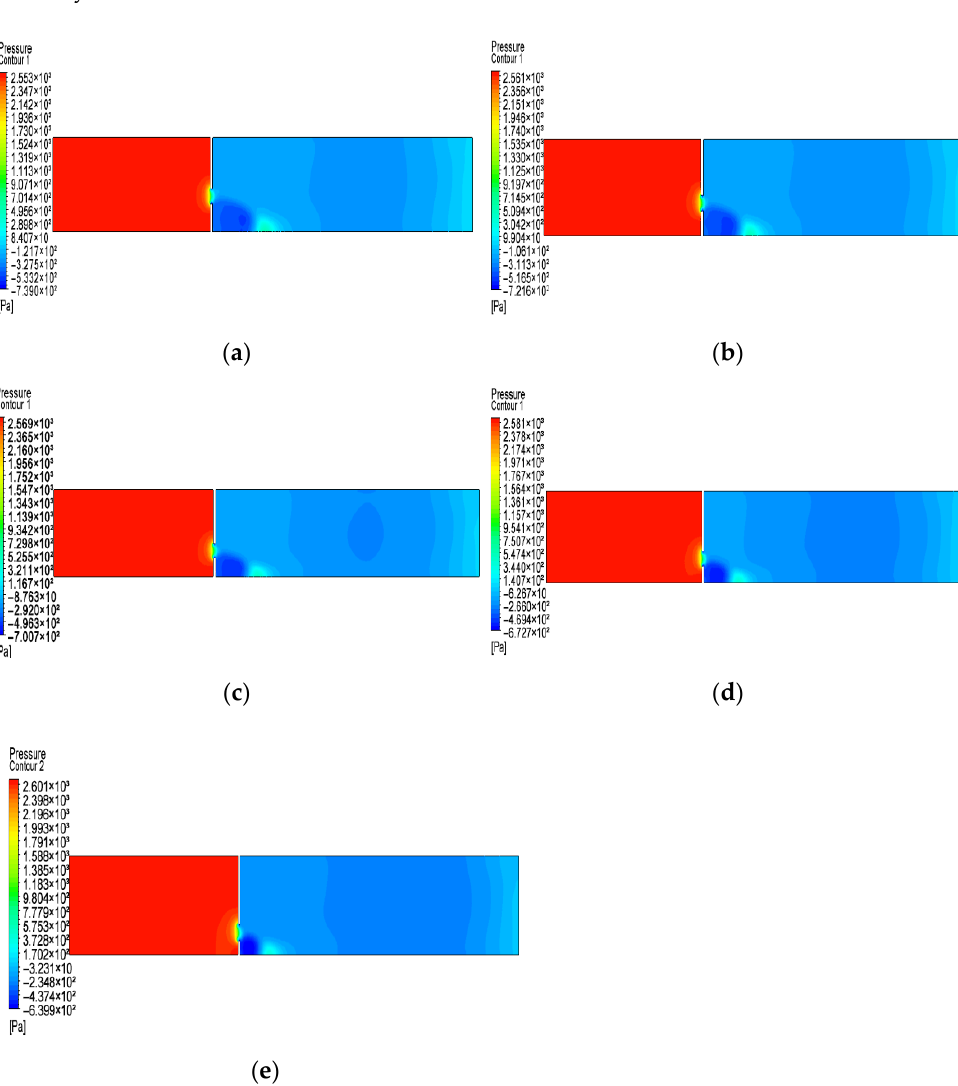
wall Table 7. Model initial conditions. Initial Condition